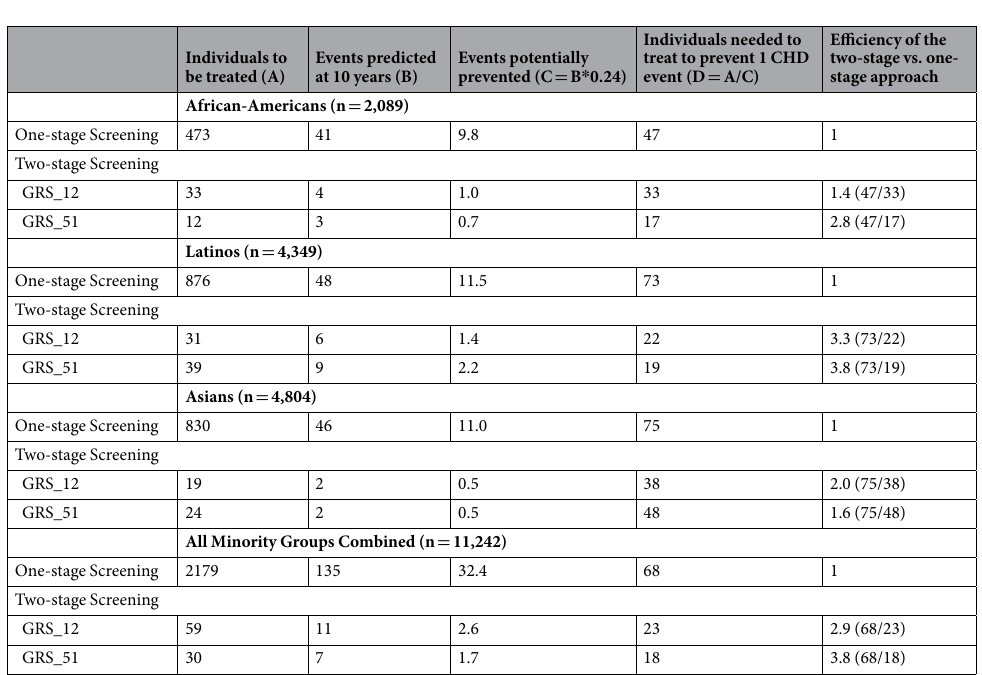
Table 4. Clinical Utility Parameters for Incident CHD for the Two GRS among GERA Subjects of Minority Descent Classified as Intermediate Risk. CHD denotes coronary heart disease; GRS denotes genetic risk